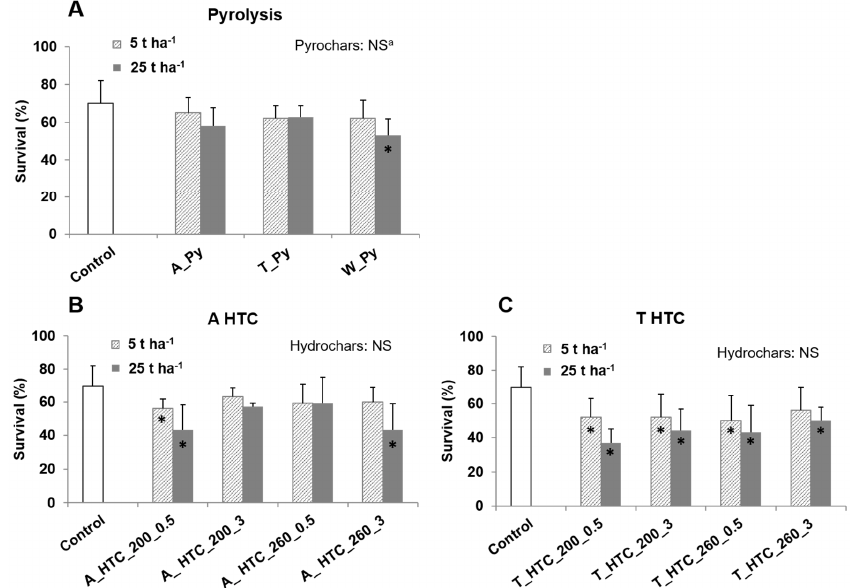
Figure 2. Survival rate (%) of Lolium perenne in: ( A ) Control and pyrochars-amended pots, ( B ) Control and pots amended with hydrochars derived from A_SS and ( C ) Control and pots amended with hydrochars derived from T_SS. Hydrochars were produced from primary (A_) and secondary (T_) sewage sludges at 200 ° C (_HTC_200) and 260 ° C (_HTC_260) for 0.5 and 3 h (_0.5, _3, respectively). Pyrochars were produced from primary (A_) and secondary (T_) sewage sludges (_Py). NS: no significance. Asterisks inside the bars show significant differences to the control according to the t -test.